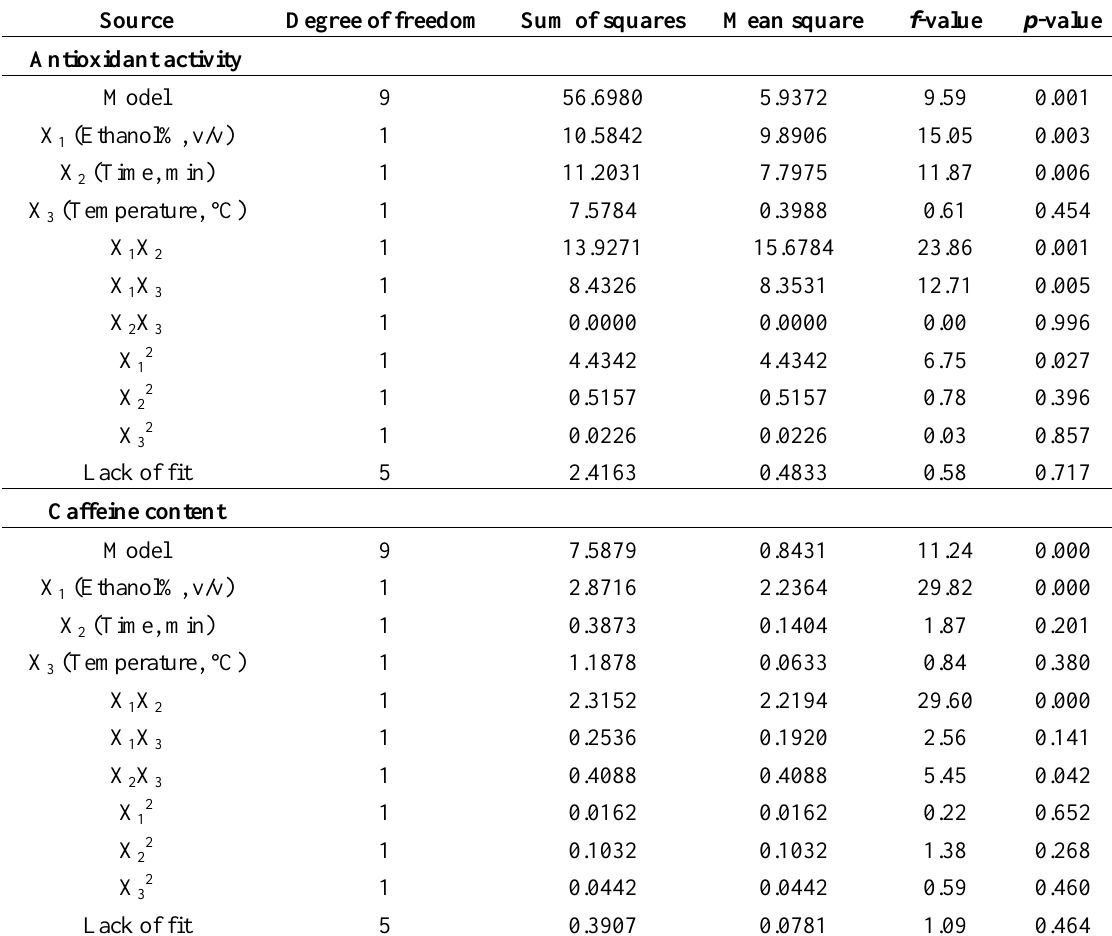
Table 3. Analysis of variance results for the regression